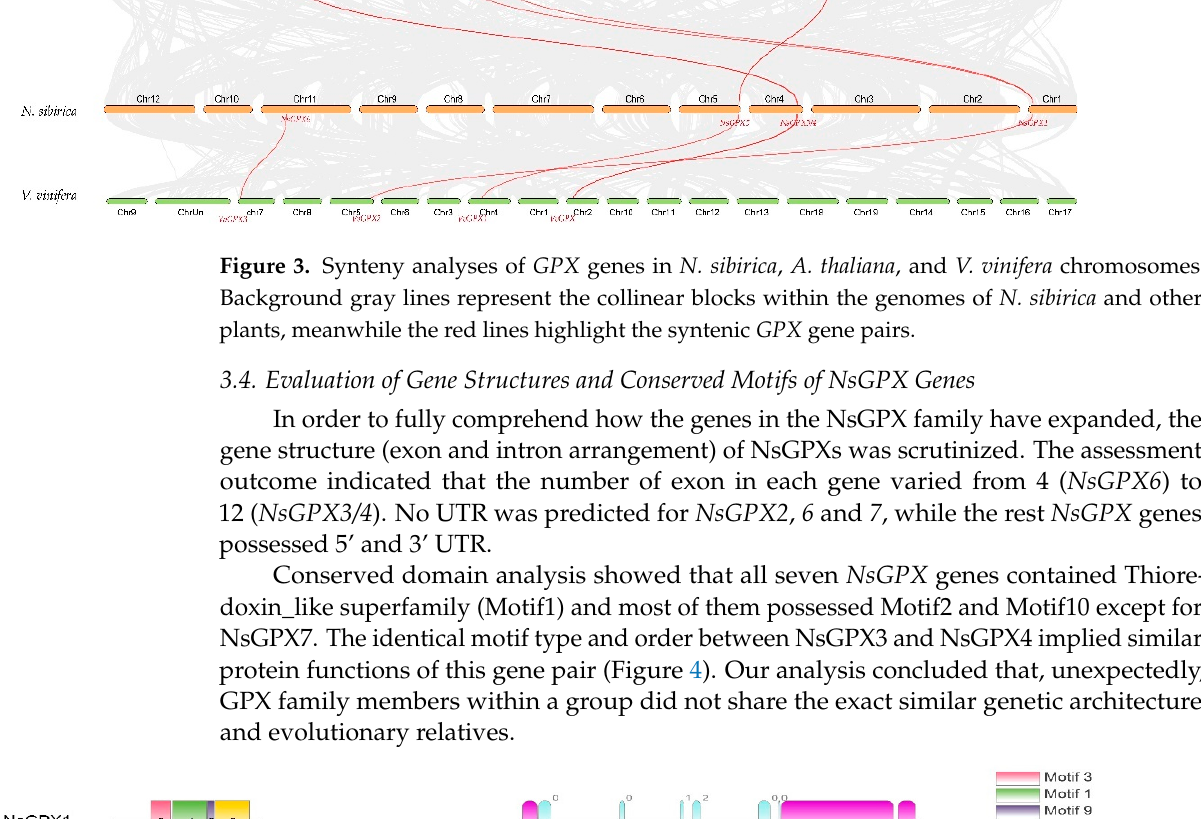
6 of 12 Figure 2. Chromosome location of NsGPX genes. Each chromosome gene names of each GPX genes on the right side coincide to their approximate locations. 3.3. Collinearity Analysis of NsGPX Genes Intraspecies collinearity analysis showed that no gene pair existed among these NsGPX s. Interspeci fi c covariance analysis demonstrated substantial orthologs of the GPX genes when it comes to N. sibirica , A. thaliana and V. vinifera (Figure 3). 5 NsGPX genes exhibited syntenic links with 4 AtGPX s and 4 VvGPX s. Predominantly, most homologues